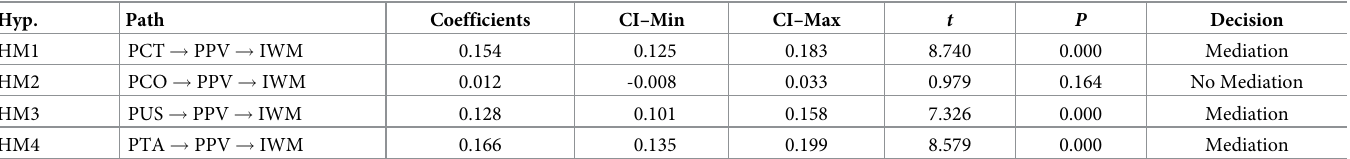
Table 4. Mediating